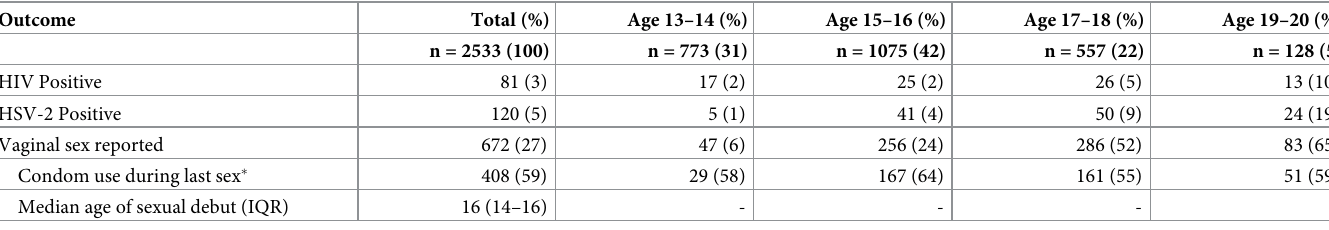
Table 3. Outcomes overall and by age